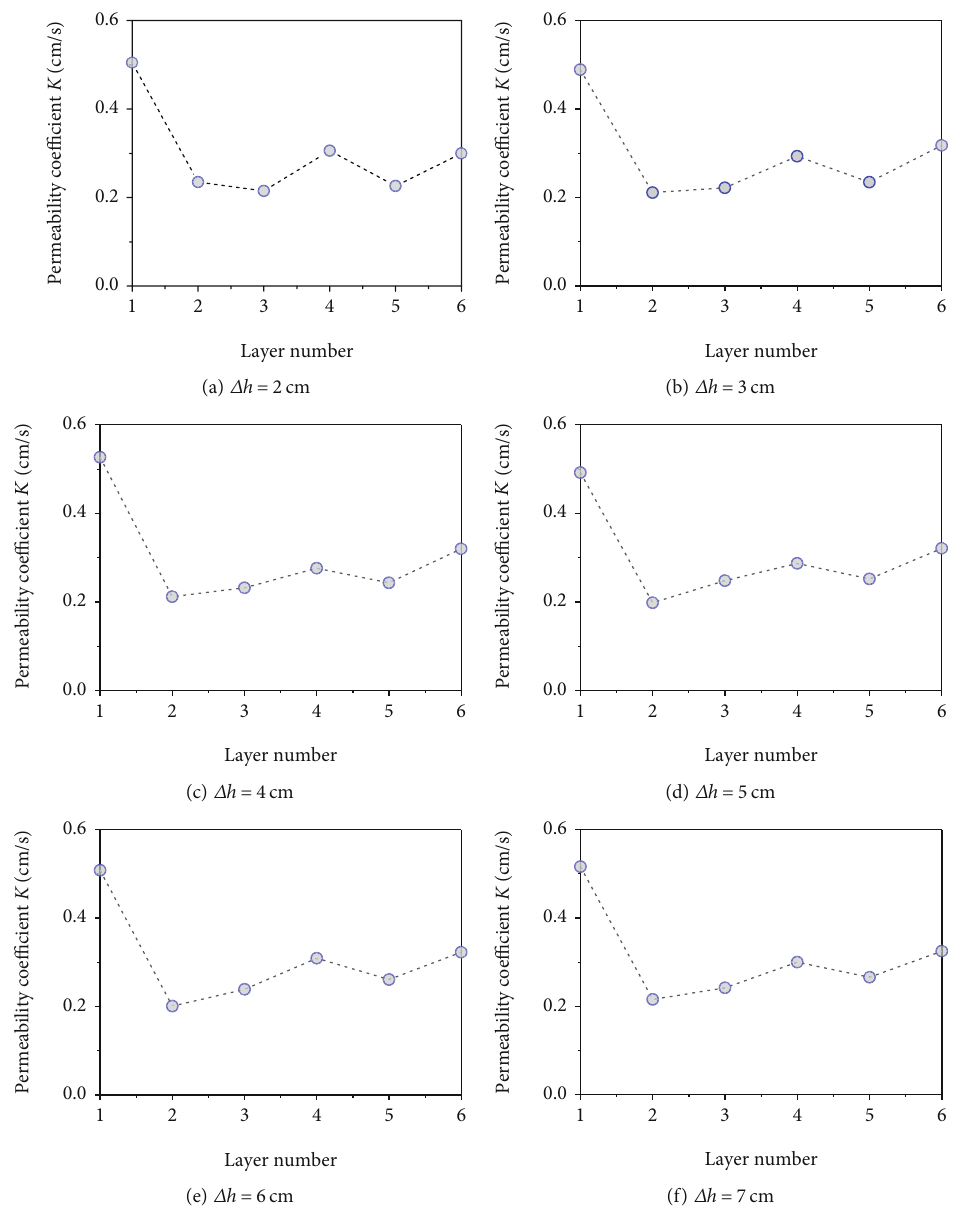
Figure 12: Variation of the permeability coe ffi cient of the slotted tube overlay geotextile with geotextile layer